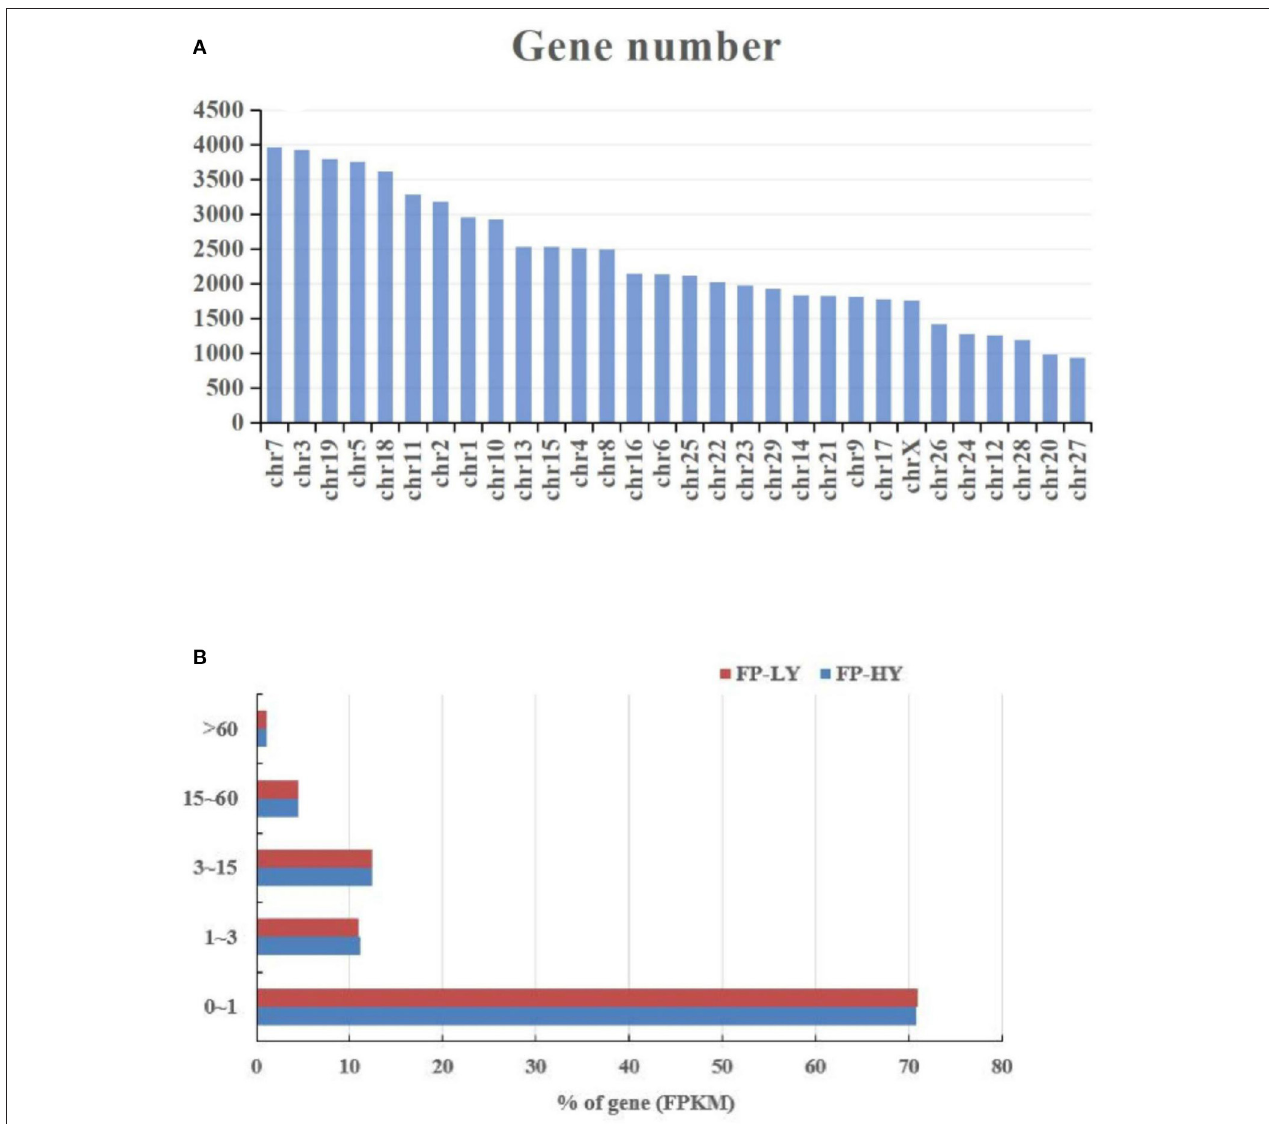
FIGURE 1 | Chromosome (A) and FPKM (B) distribution of identified genes in FP-HY and FP-LY comparison.